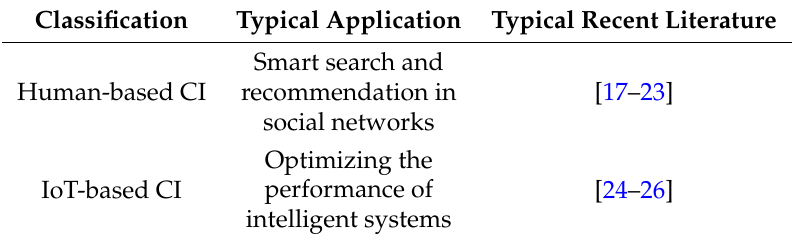
Table 1. Classification of the studies on collaborative intelligence